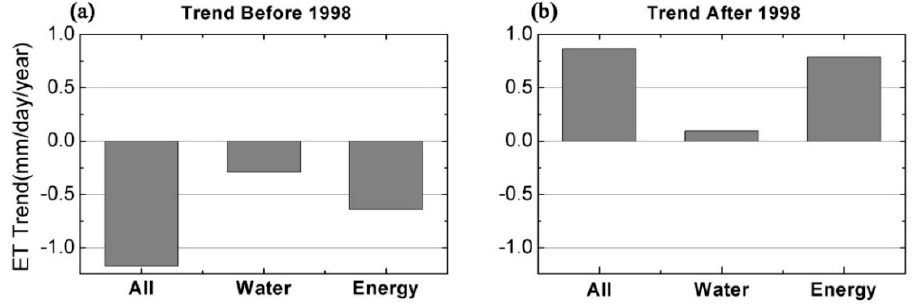
Figure 7. The average ET trends of 1989–1998 ( a ) and 1998–2005 ( b ) in China and the two divided regions. “All” represents the general trend of ET in China, “Water” represents the water-control region, and “Energy” represents the energy-control region.